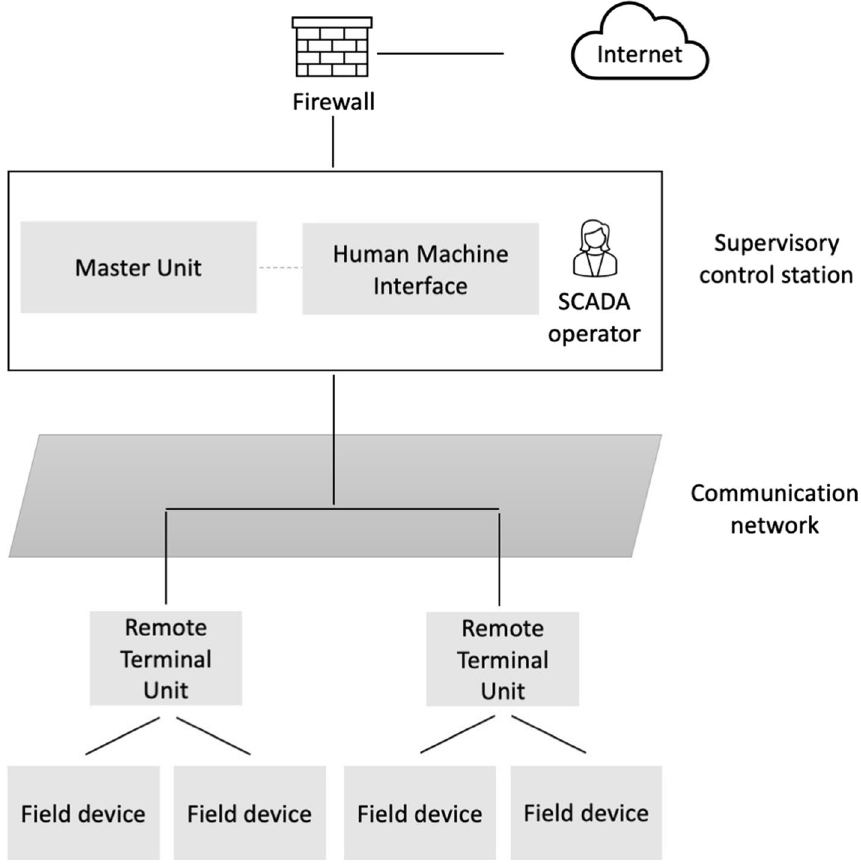
Fig. 1 Abstraction of SCADA system (Zhu et al. 2011; Maynard et al.